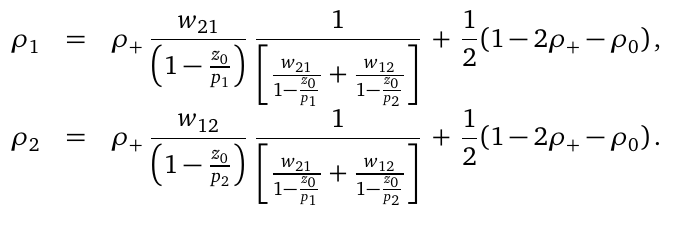
and flip rate w respectively in 0 12 0